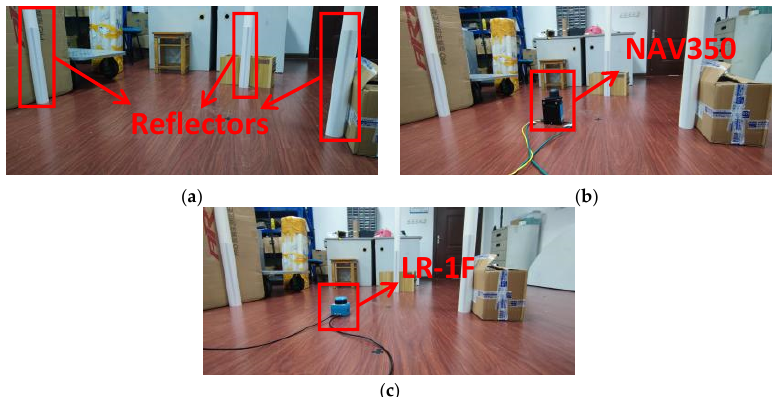
Figure 16. The experiment of fitting the coordinates of the reflectors. ( a ) Reflectors were placed close to flat planes. This simulated placement of reflectors in real scenes. ( b ) NAV350 scanned the reflectors and calculated distances between reflectors. ( c ) LR-1F scanned the reflectors and calculated distances between reflectors.